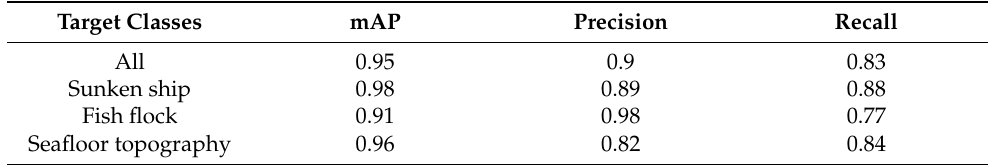
Table 4. The evaluation indicators for three kinds of side scan sonar datasets based on the YOLO V3 + SPP with online datasets preprocessing